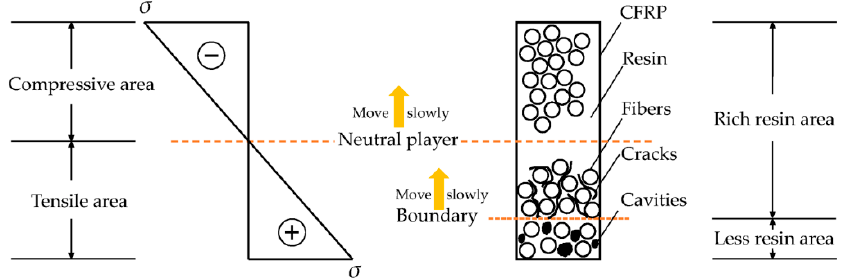
Figure 19. Schematic sketch of the effects of sustained bending on CFRPs immersed in water/seawater in the long run.